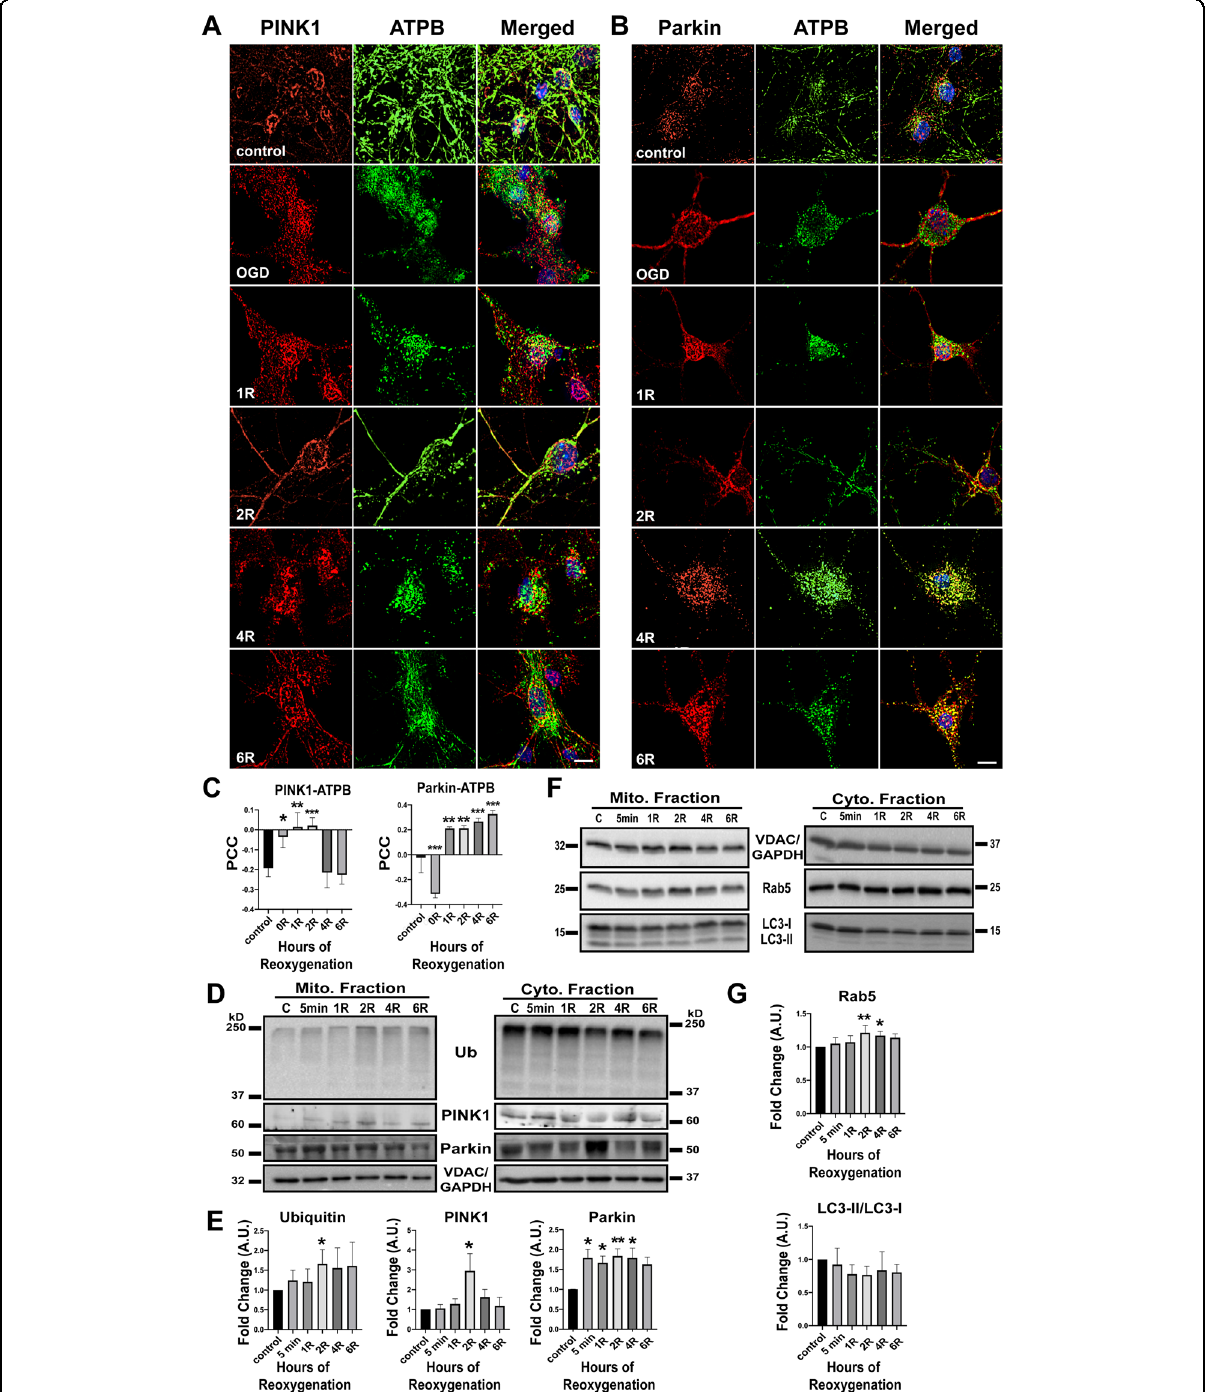
Fig. 2 PINK1/Parkin-mediated mitophagy. A Cells labeled with PINK1 and ATPB for colocalization of PINK1 with mitochondria, n = 4. B Cells labeled with Parkin and ATPB for colocalization of Parkin with mitochondria, n = 3. C Quanti fi cation of colocalization using Pearson ’ s correlation coef fi cient (PCC). D Western Blot of mitochondrial and cytosolic fractions for PINK1, Parkin, and ubiquitin. E Quantitation of protein levels, normalized to VDAC and GAPDH, Ubiquitin: n = 6, PINK1: n = 5, Parkin: n = 8. F Western Blot of LC3 (autophagy marker) and Rab5 (endosome marker) in mitochondrial and cytosolic fractions. G Quantitation of LC3 conversion and Rab5, normalized to VDAC and GAPDH, LC3: n = 4, Rab5: n = 4. Differences between groups were computed using one-way ANOVA with Dunnett ’ s post-hoc analysis for comparisons versus control. R post- reoxygenation; * p < 0.05; ** p < 0.01; *** p < 0.001. Scale bar = 10